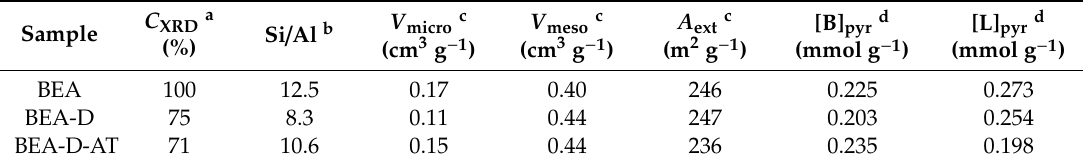
Table 1. Degree of crystallinity, C XRD , Si / Al ratio, textural parameters, and Brønsted, [B] pyr , and Lewis [L] pyr , acidic sites concentration